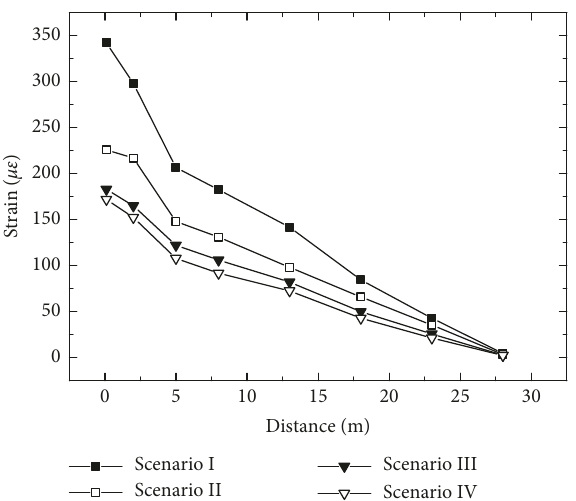
Figure 17: Trend of the maximum dynamic strain variation.